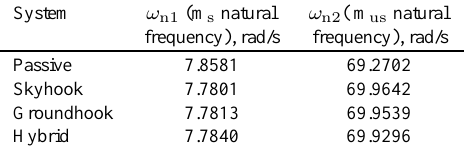
Table 3 Natural frequencies of each system and control